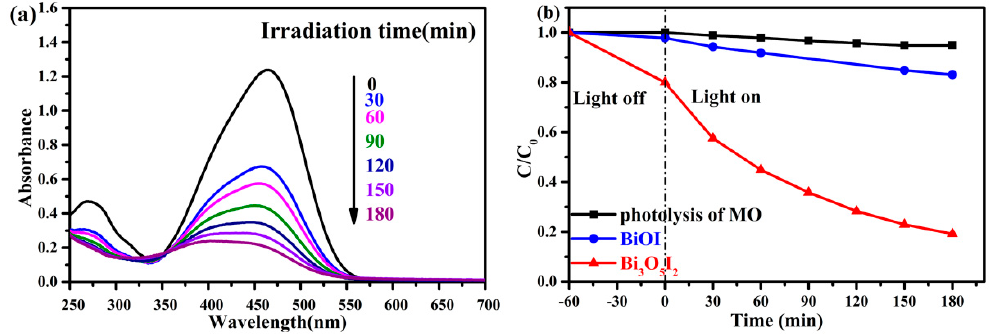
Figure 9. ( a ) The UV-Vis absorption spectral changers during the degradation of MO (20 mg / L), ( b ) photocatalytic decomposition of MO in the presence of Bi 3 O 5 I 2 and BiOI and photolysis of MO under simulated visible light irradiation.